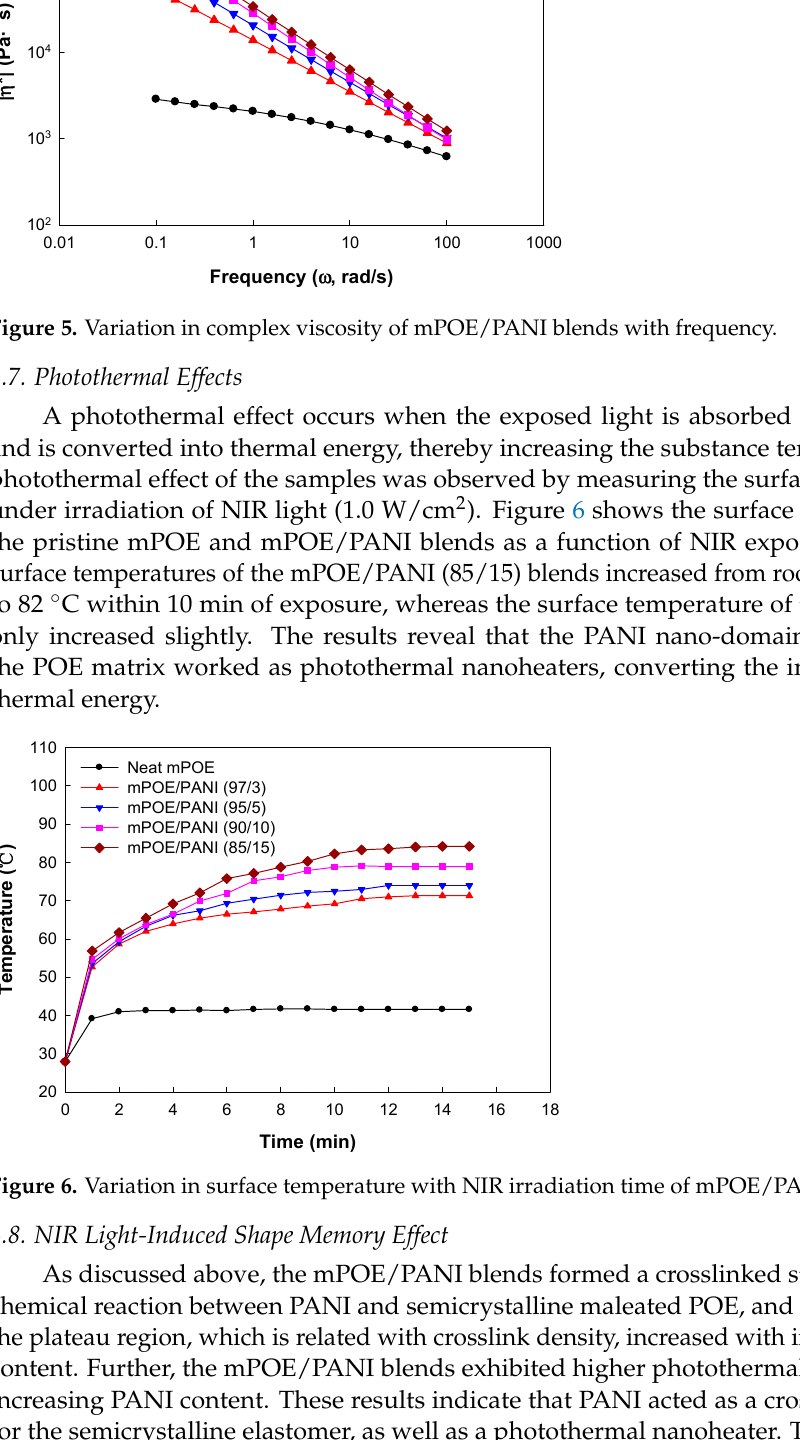
Figure 6. Variation in surface temperature with NIR irradiation time of mPOE/PANI blends.